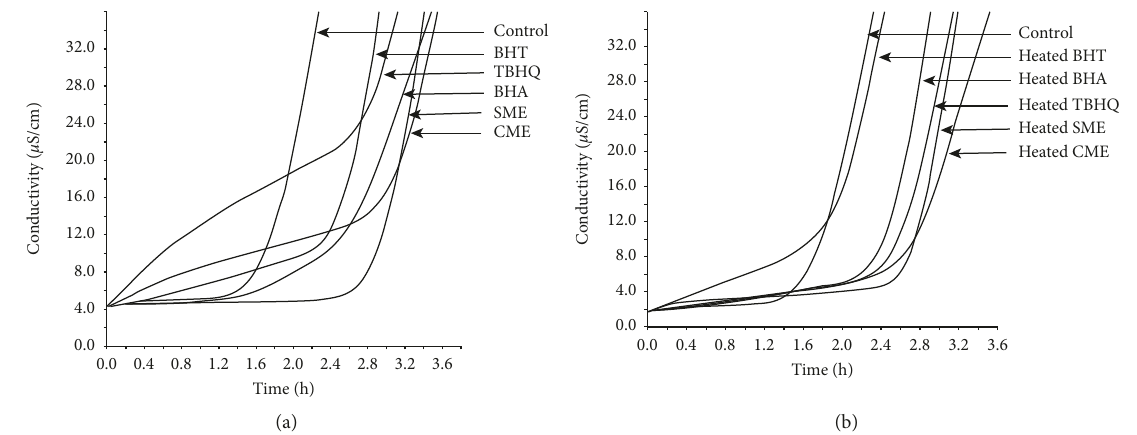
Figure 1: Induction time (IT) for the formation of oxidation products in sunflower oil. Variation of ITof sunflower oil with (a) antioxidants kept at room temperature and (b) heated antioxidants. Table 2: Stability parameters of sunflower oil with added antioxidants (100mg/kg oil). Antioxidant in sunflower oil